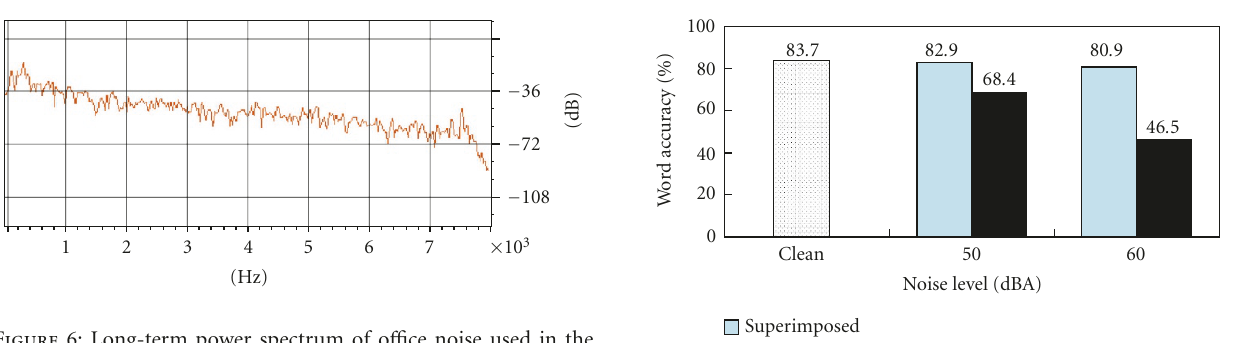
Figure 6: Long-term power spectrum of o ffi ce noise used in the experiments.